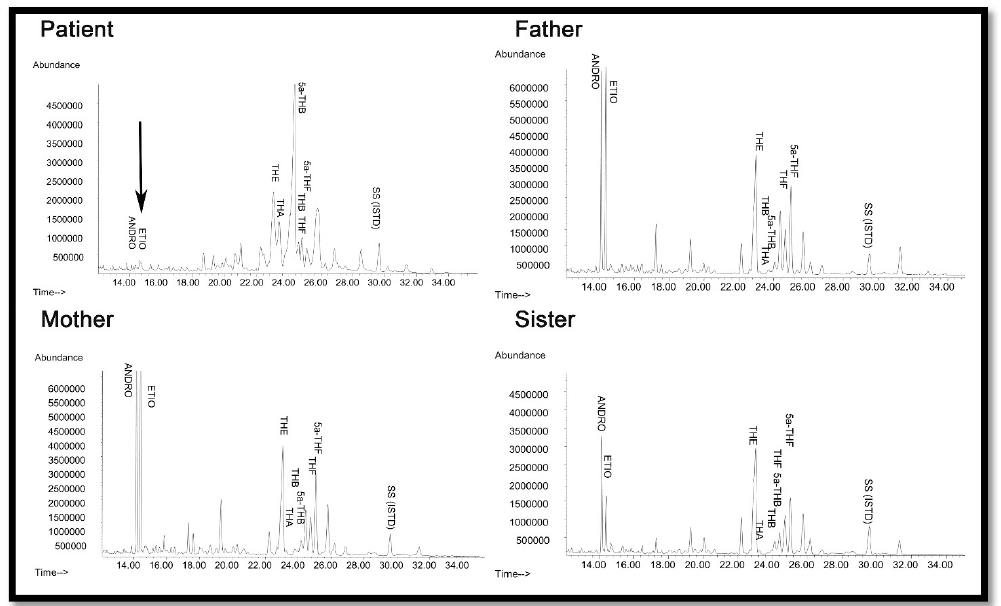
Figure 4. Urine steroid profile of the patient, heterozygote mother, father, and sister. The steroid analysis was performed on 24 h urine samples by GC/MS. Note the lack of androgens (ETIO, ANDRO) and the relative increase in corticosterone metabolites (THA, THB, 5α-THB) in the steroid profile of the patient compared to mother and father. THA—tetrahydro-11-dehydrocorticosterone; THB— tetrahydro corticosterone; 5a-THB-5α-tetrahydro corticosterone; THE—tetrahydrocortisone; THF— tetrahydrocortisol; 5a-THF-5α-tetrahydrocortisol; ETIO—etiocholanolone; ANDRO—androsterone; SS (ISTD)—internal standard.